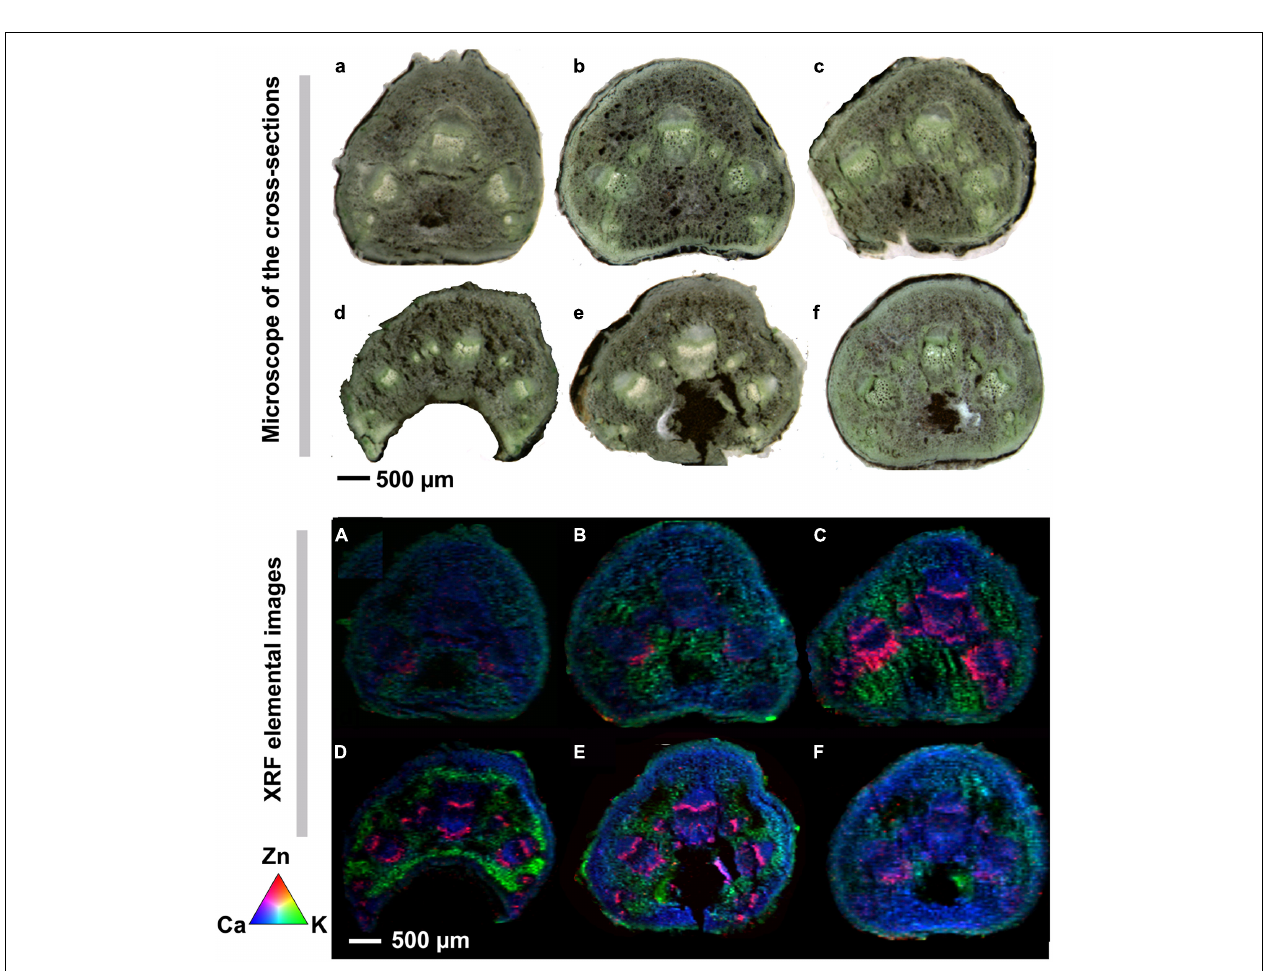
CleanStart + Kick-Off + GroZyme, and (f, F) ZnSO 4 , and then analyzed by μ -XRF imaging. Compositions of the nutrients in different treatments are shown in Table 1 . Pixel brightness for μ -XRF map (A–F) is displayed in RGB, with the brightest spots corresponding to the highest element fluorescence. Scale bar: 500 μ